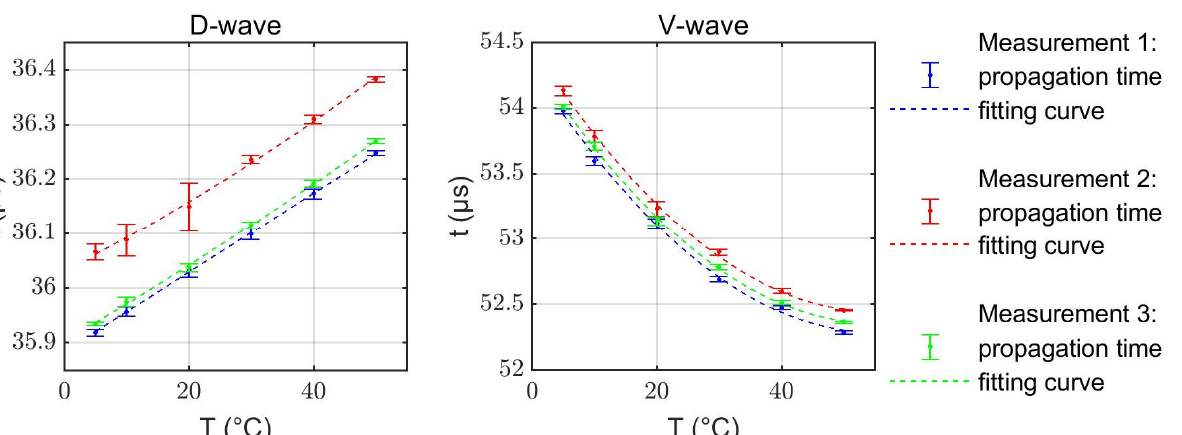
Figure 4. Experimentally measured propagation times t D and t V depending on the temperature in a range from 5 °C to 50 °C. The vertical offset in the curves is related to variations in the transducer attachment on the different sensors or variations in limescale layer thickness. The second set of data stems from a measurement series with step-by-step decreasing